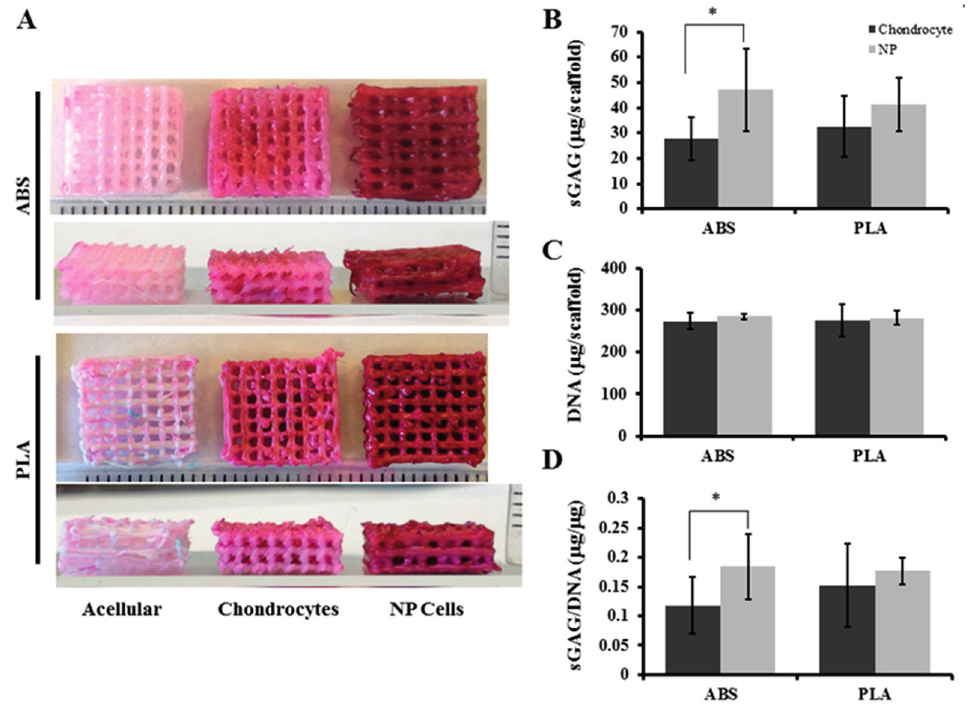
Figure 5. Proteoglycan analysis of scaffolds. ( A ) Fixed acellular, chondrocyte-, and NP-seeded ABS and PLA scaffolds were stained with safranin-O/fast green after 21 days’ culture. Representative images ( n = 4) showing that both chondrocyte- and NP-seeded ABS and PLA scaffolds retained intense safranin-O staining. Ruler ticks represent millimeters; ( B ) DMMB assay for quantifying sulfated GAG in total extract per scaffold (in 1 mL); ( C ) DNA content was quantified by HOECHST 33258 assay per scaffold; ( D ) The sGAG/DNA ratio was determined. Error bars represent ± SD. * indicates p < 0.05. 2.4. Chondrocytes and NP Cells Produce Collagen Type II on ABS and PLA Scaffolds Western blot analysis of protein extracts from chondrocyte and NP-seeded ABS and PLA